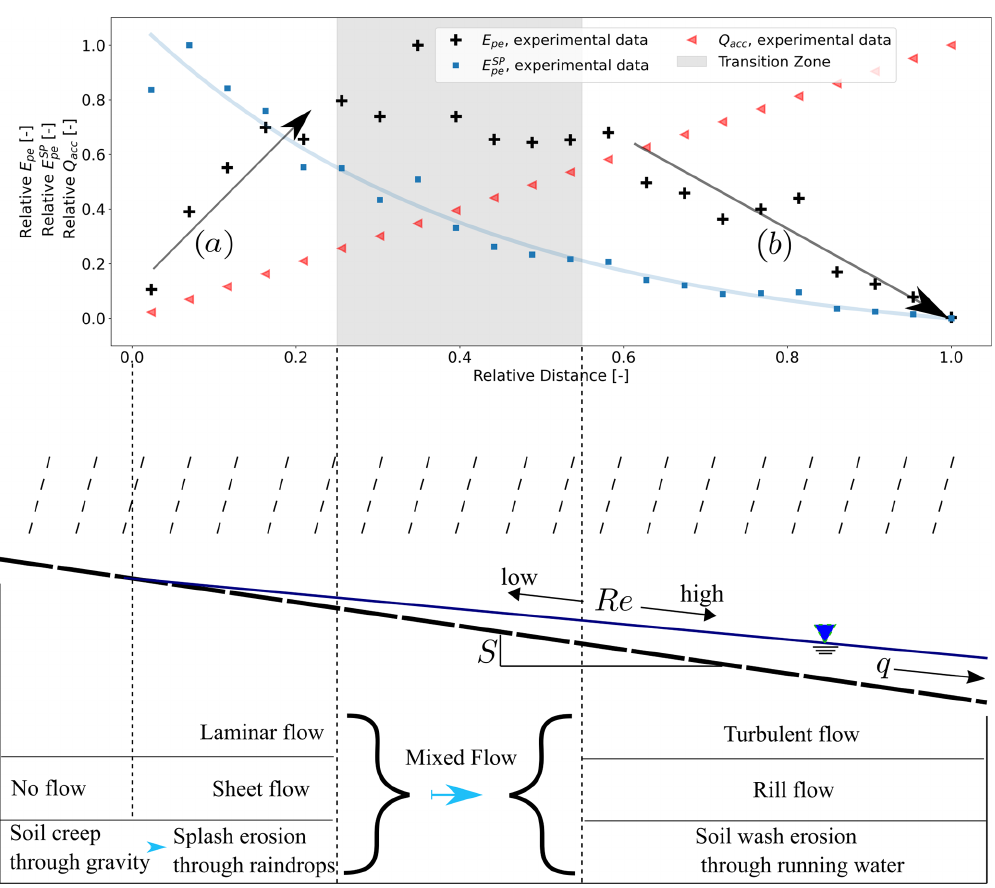
Figure 2. Upper part: digitized results from rainfall simulation experiments at New Fork River 1 (Emmett, 1970), expressed as normalized potential energy E pe , specific potential energy E pe , SP and Reynolds number Re . Lower part: simplification of overland flow processes on f f hillslopes (modified after Shih and Yang, 2009) as a function of Reynolds number Re and distribution of potential